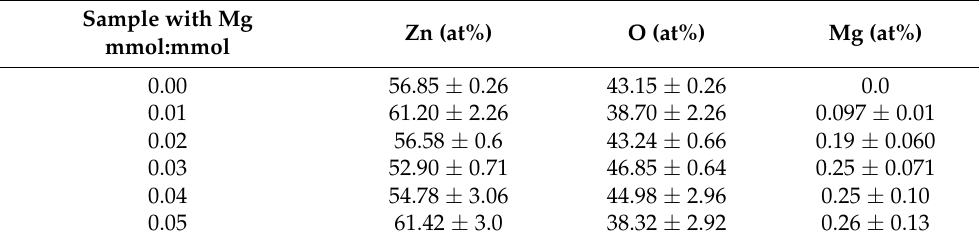
Table 2. The EDX spectra results of the undoped ZnO and Mg-doped ZnO samples. Sample with Mg Zn (at%) O mmol:mmol